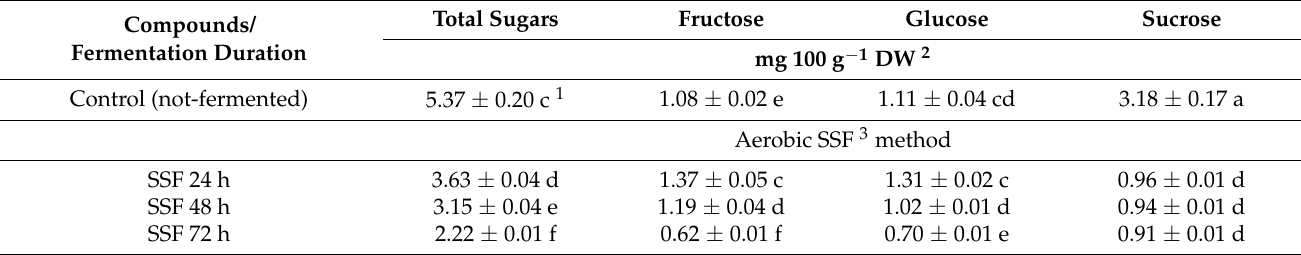
Table 4. The contents of total sugars, fructose, glucose and sucrose in willow herb leaves fermented under the different fermentation methods and